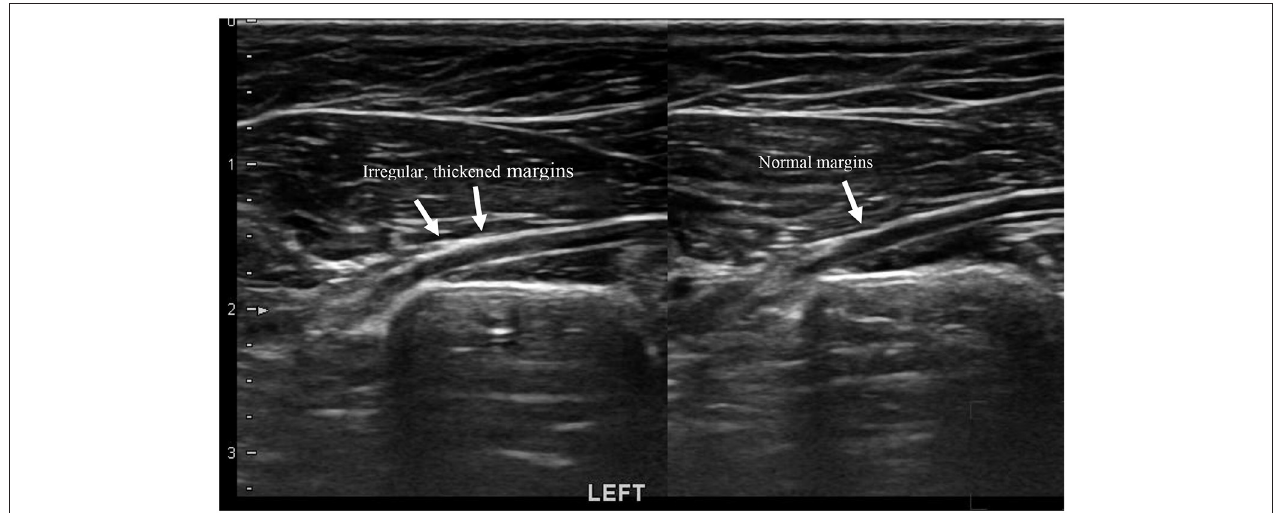
FIGURE 3 | Linear image of a sciatic nerve with neuritis. There are irregular thickened margins noted on the left sciatic